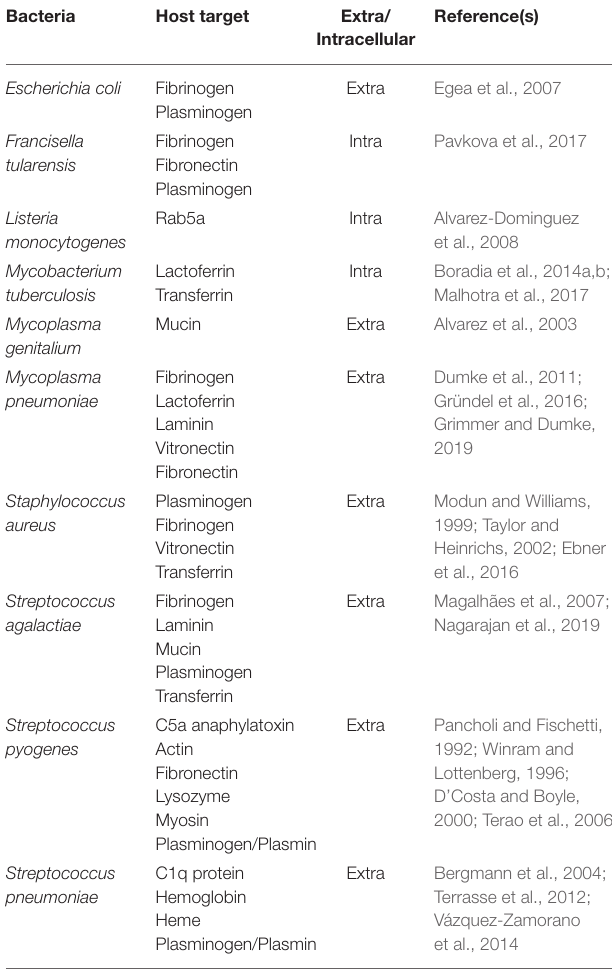
TABLE 1 | Binding of bacterial GAPDH to host